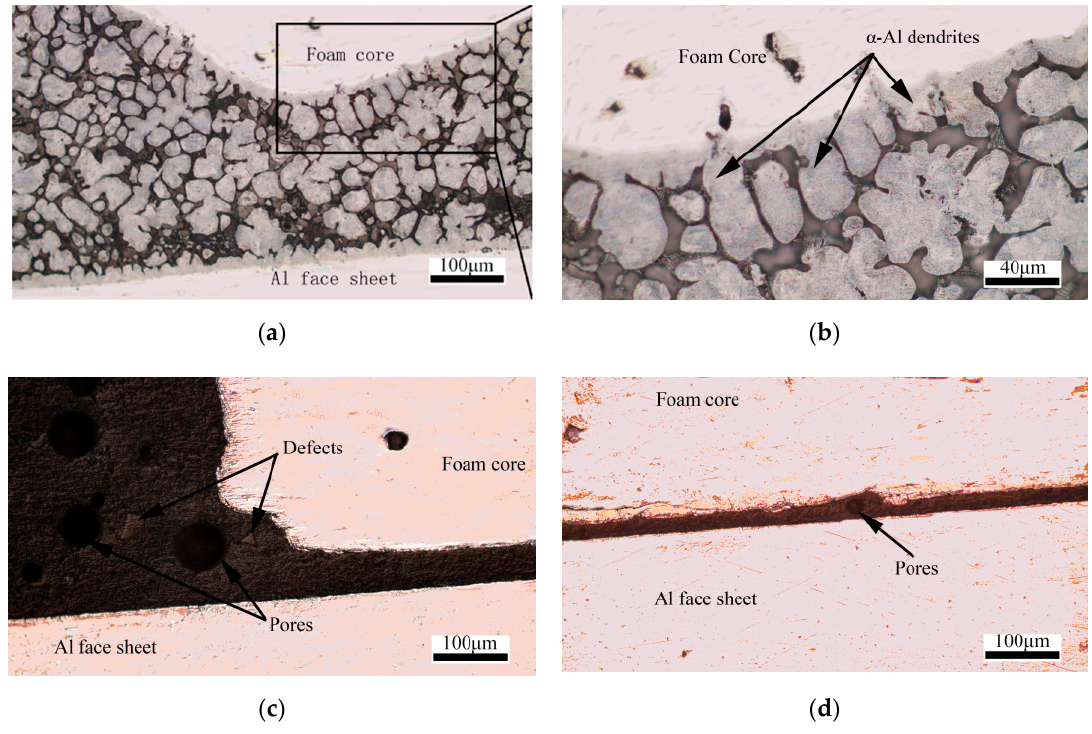
Figure 3. Optical microscope images of AFS joining parts ( a , b ) Metallurgical joining ( c , d ) Adhesive joining.